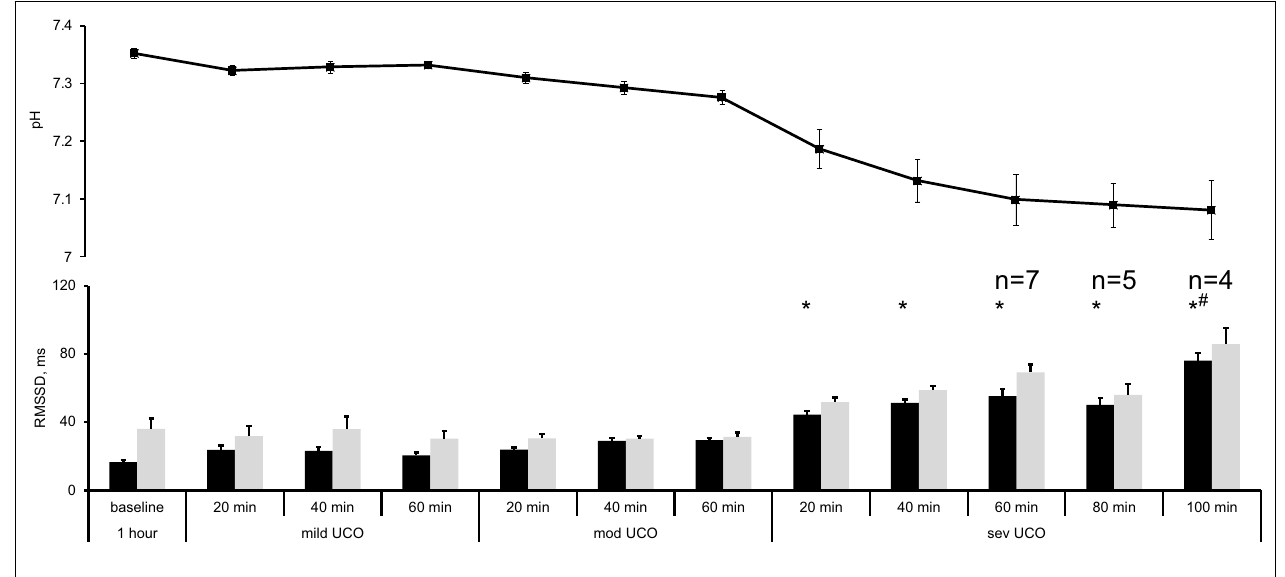
100min.” Accordingly, sample sizes of these time points were lower where indicated. For other time points, N = 9. Mean ± SEM. * p < 0.05 versus baseline for 1000Hz sampled fHRV; # versus baseline for 4Hz sampled